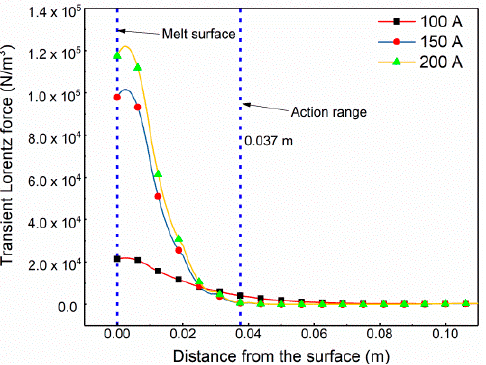
Figure 8. Lorentz force distribution along the tracking path.